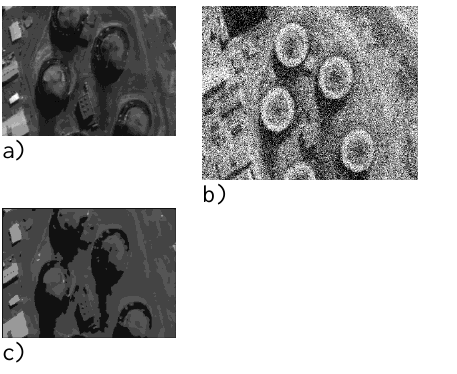
Figure 9. Example 4: a) etalon TV fragment; b) test IR image; c) segmented TV fragment.